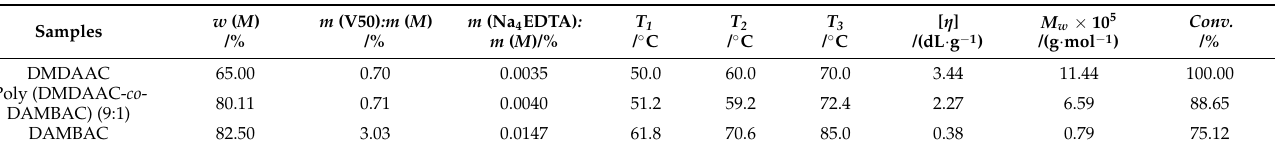
Table 7. Summary of the best process conditions for copolymerization of monomers with different copolymerization